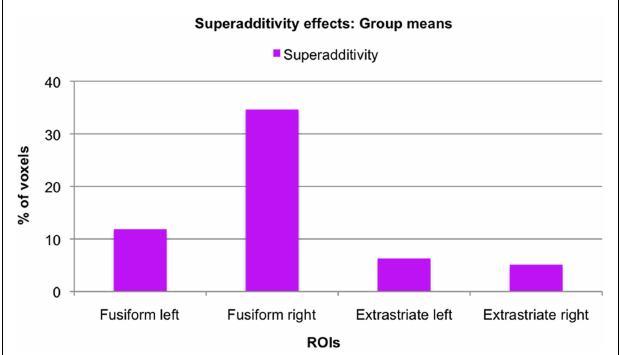
FIGURE 8 | Size of superadditivity effects: Group means. For each ROI, the graph displays the mean percentage of voxels of the original SFSB condition specific adaptation effects that also showed superadditivity, that is where the SFSB adaptation effect was bigger than the sum of the adaptation effects of all other conditions.